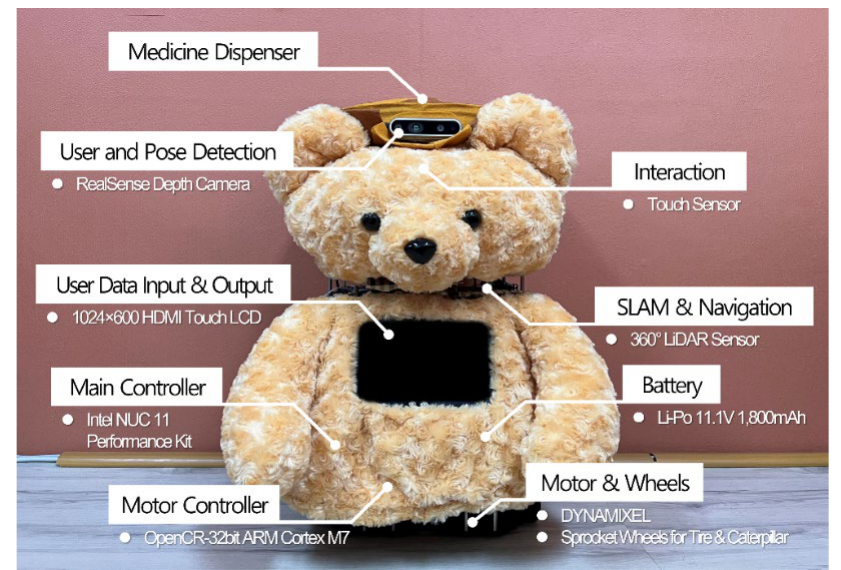
Figure 2. Hardware components of care robot DORI.